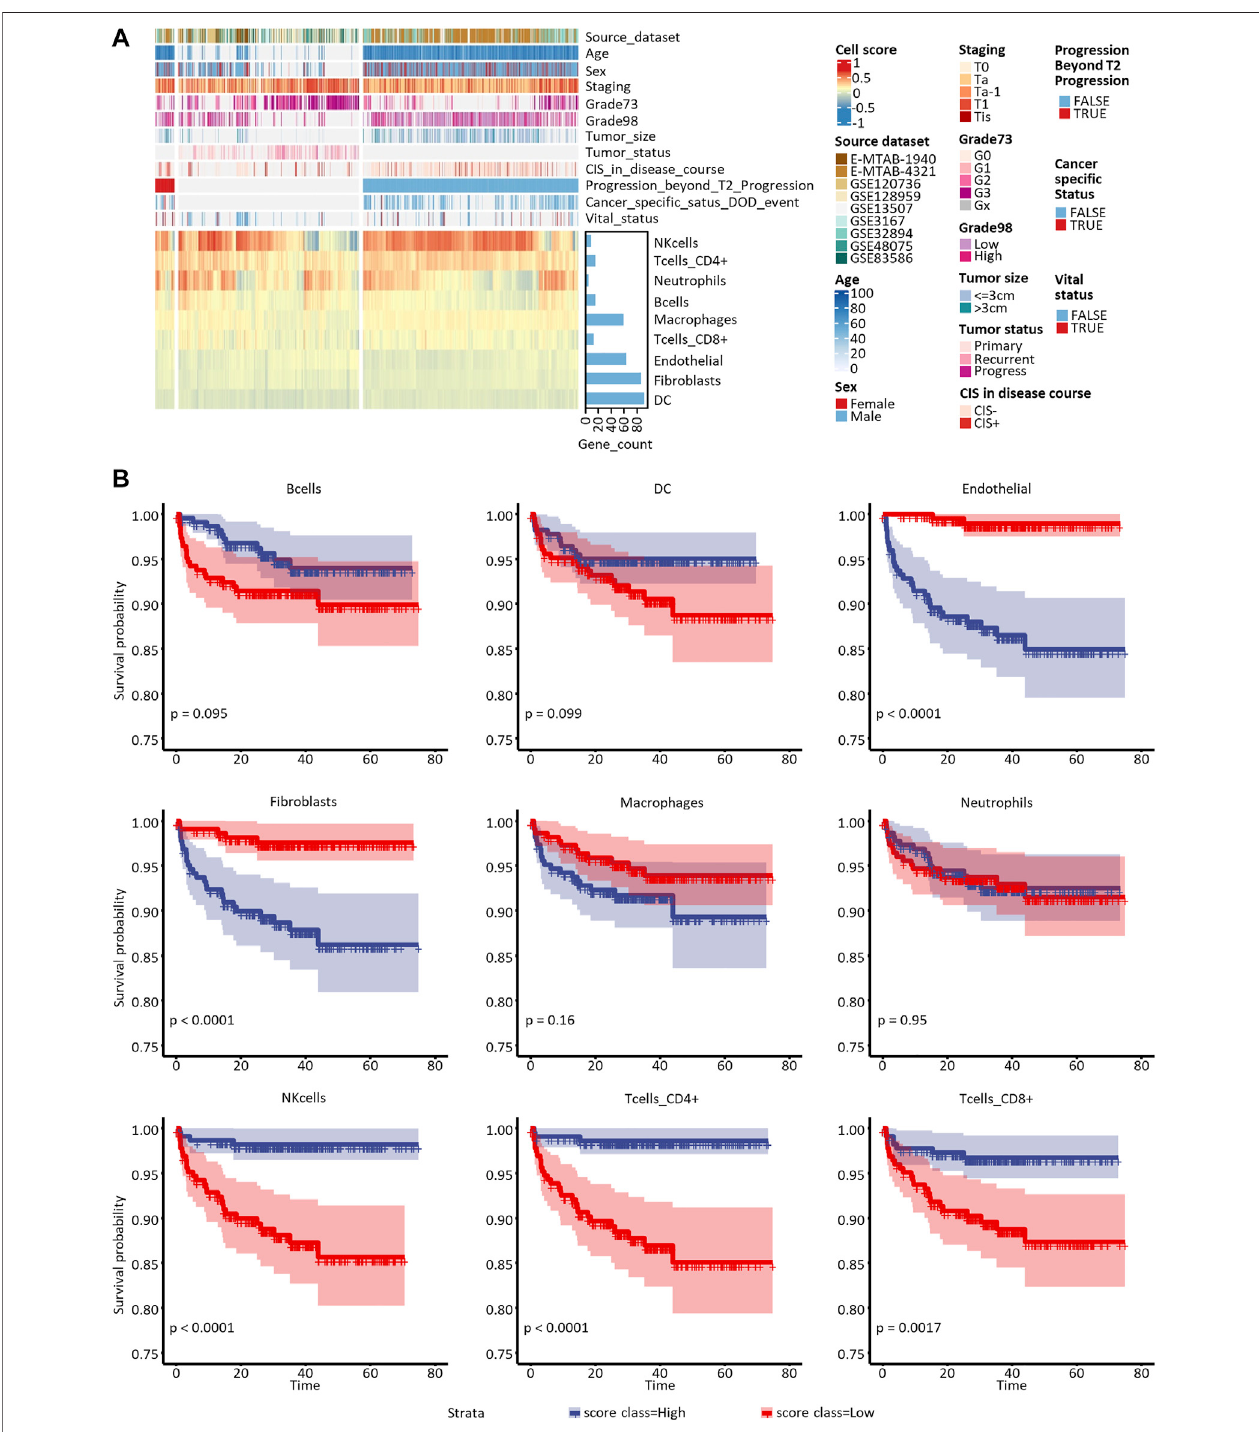
FIGURE4| Proportion assessment and prognostic valueofthe nine candidate tumor-in fi ltratingcells. (A) Heatmapofcandidate cellsand clinicalfeaturesofall the eligible 1,370 samples included in this study. Grade73 and Grade98 refer to the WHO 1973 and WHO 2004/2016 Classi fi cation Systems for Urothelial Carcinoma, respectively. (B) Kaplan-Meier curves of univariate Cox regression in low- versus high-in fi ltrated groups divided by the nine candidate immune or stromal cells.